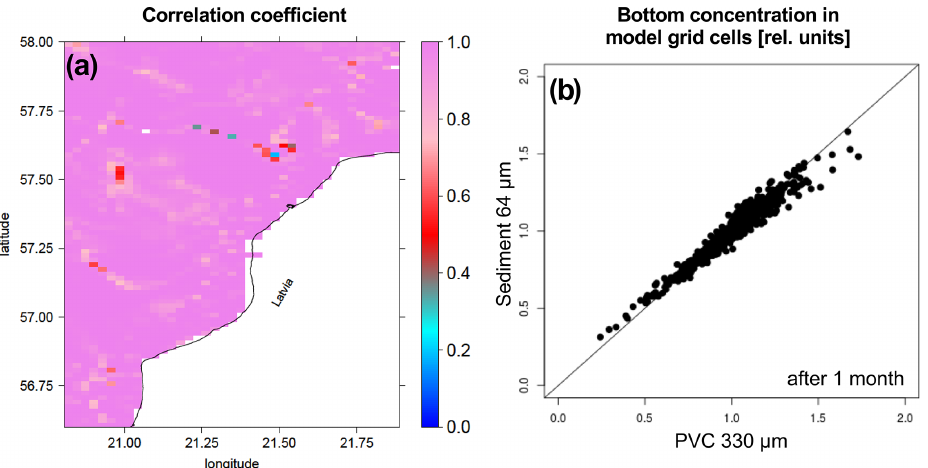
Figure 13. (a) Pearson correlation between the time series of bottom concentrations of PVC with a 330µm diameter and sediment with a 64µm diameter for January 2019. (b) Scatter plot of bottom concentrations after the 1-month simulation. Concentrations are given relative to the homogenous initial